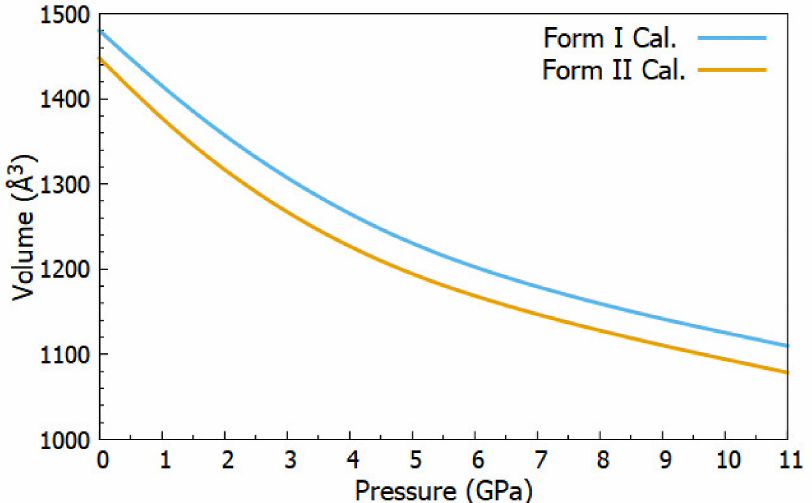
Figure 2. Pressure-dependent volume changes of TCBZ form I (blue curve) and form II (orange curve) at 0 K